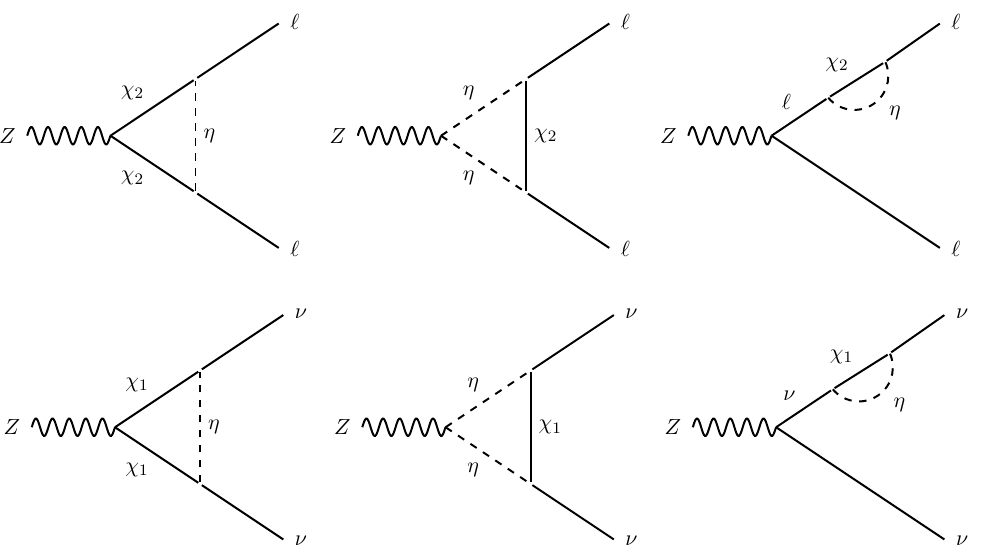
Figure 13. The leading contributions to Z ! ‘‘ and Z ! (cid:23)(cid:23) in our model. Fermion arrows omitted for brevity, such that each diagram can be associated with multiple (cid:13)ow